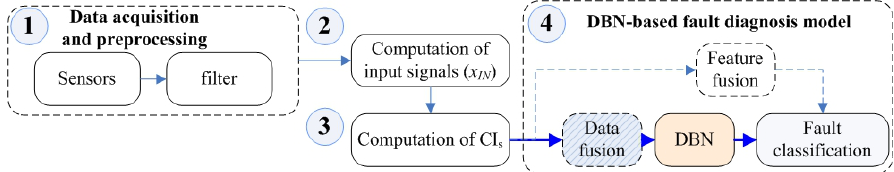
Figure 2. The basic model of